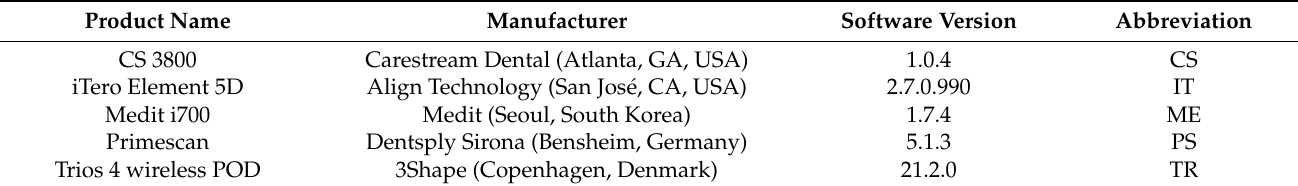
Table 1. Intraoral scanners used in this study.